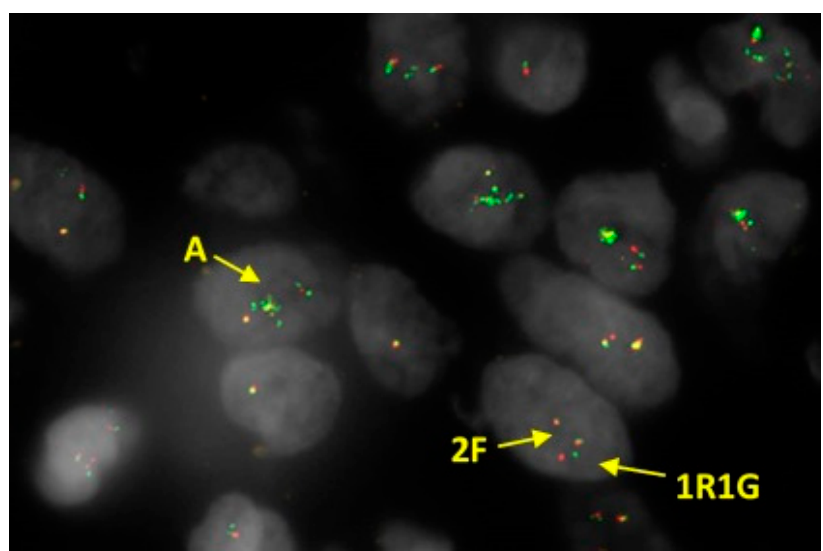
Figure 8. Fluorescence In Situ Hybridisation (FISH) performed on HG-ESS, which shows YWHAE rearrangement with amplification of the fusion signal (2F) plus additional 5' signals (A) using dual colour break apart probe. Results expressed as F (fusion signal, i.e., normal), split R (separate red signal) and G (separate green signal) rearrangement.